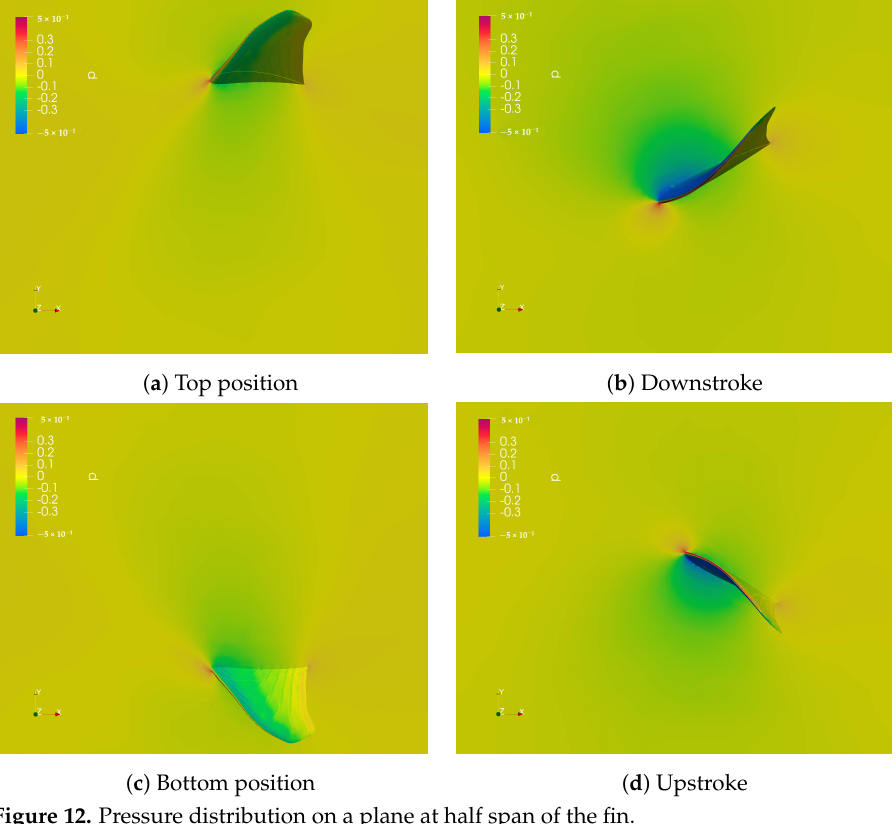
Figure 12. Pressure distribution on a plane at half span of the